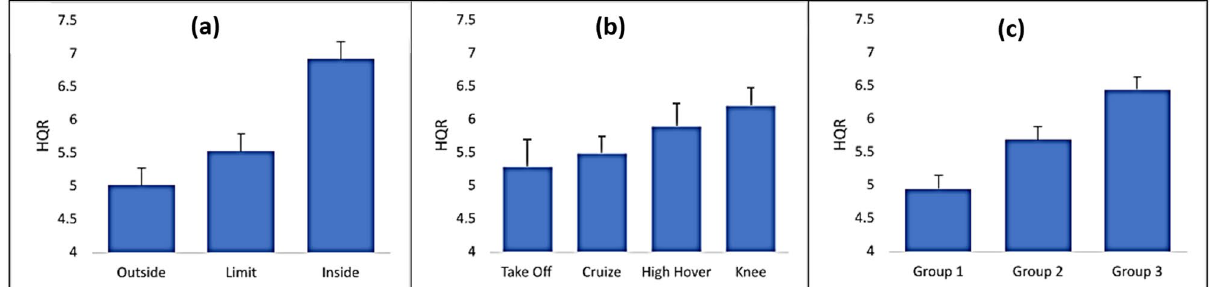
Figure 4. HQR values (mean and SEM) obtained by helicopter pilots submitted to an autorotation test at Height-Speed diagram. (a) All pilots grouped according to classical segmentation, (b) all pilots grouped according to the proposed segmentation, and (c)